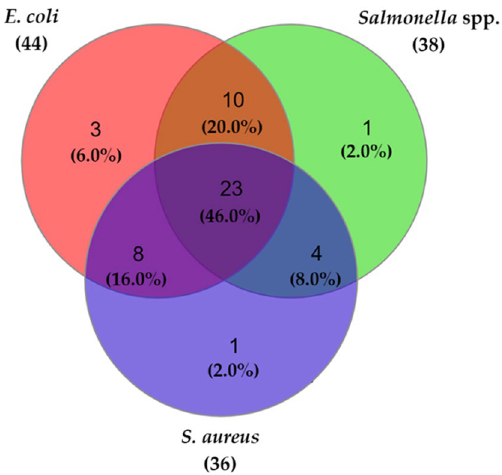
Figure 2. Venn-diagram showing co-isolation of E. coli , Salmonella spp. and S. aureus in cloacal swab.